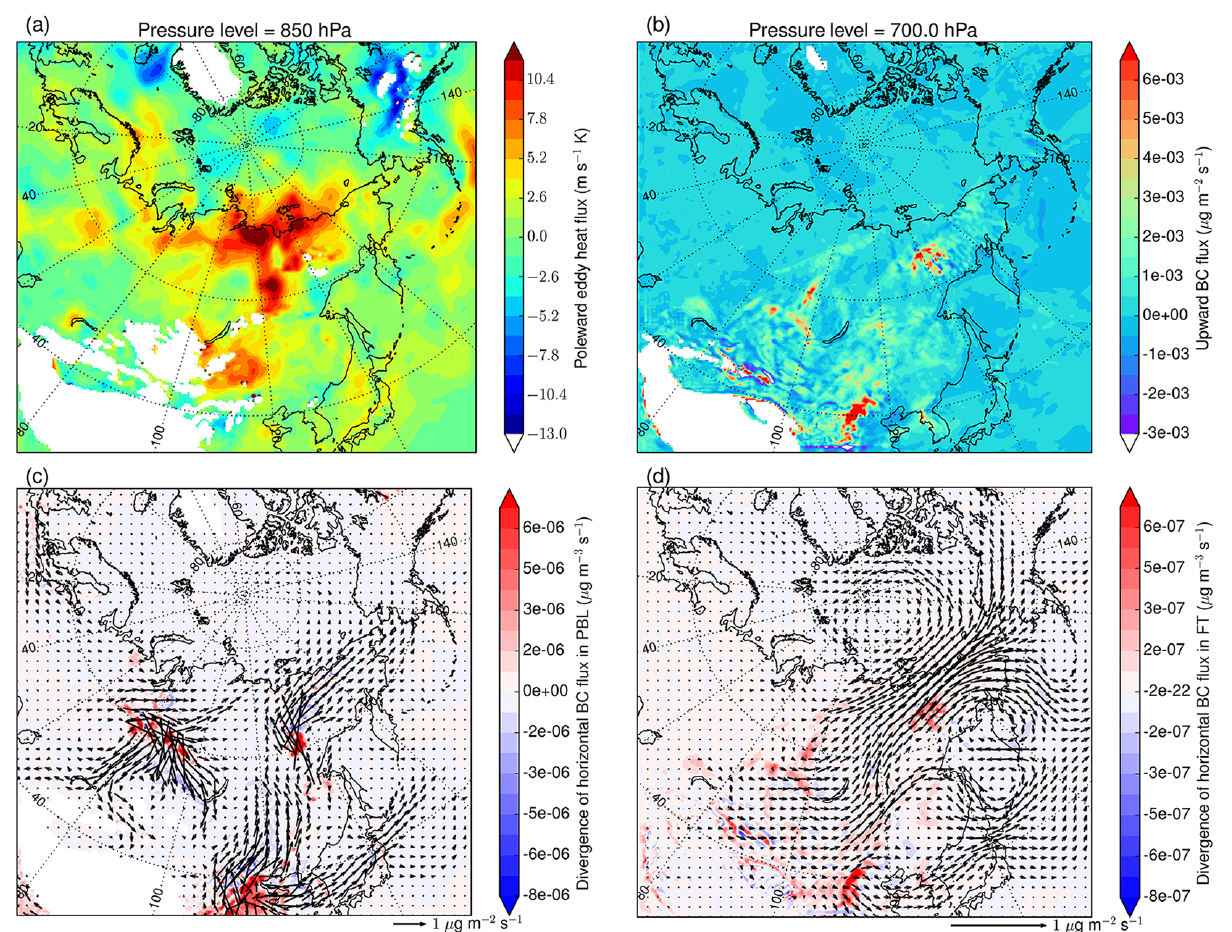
Figure 7. Time-averaged (a) horizontal poleward eddy heat flux v (cid:48) θ (cid:48) at the 850hPa level, (b) upward mass flux of BC [ BC ] w at the 700hPa level, and divergence of the horizontal mass flux of BC integrated over (c) the PBL and (d) the free troposphere (FT) during the ACCESS period in the WRF-Chem BASE simulation. Regions without data in white have a high orography (surface pressure below the plotted level). Vectors representing the time-averaged horizontal mass flux of BC integrated over the PBL and FT during the ACCESS period are shown in panels (c) and (d) respectively, as well as the scaling near the lower right